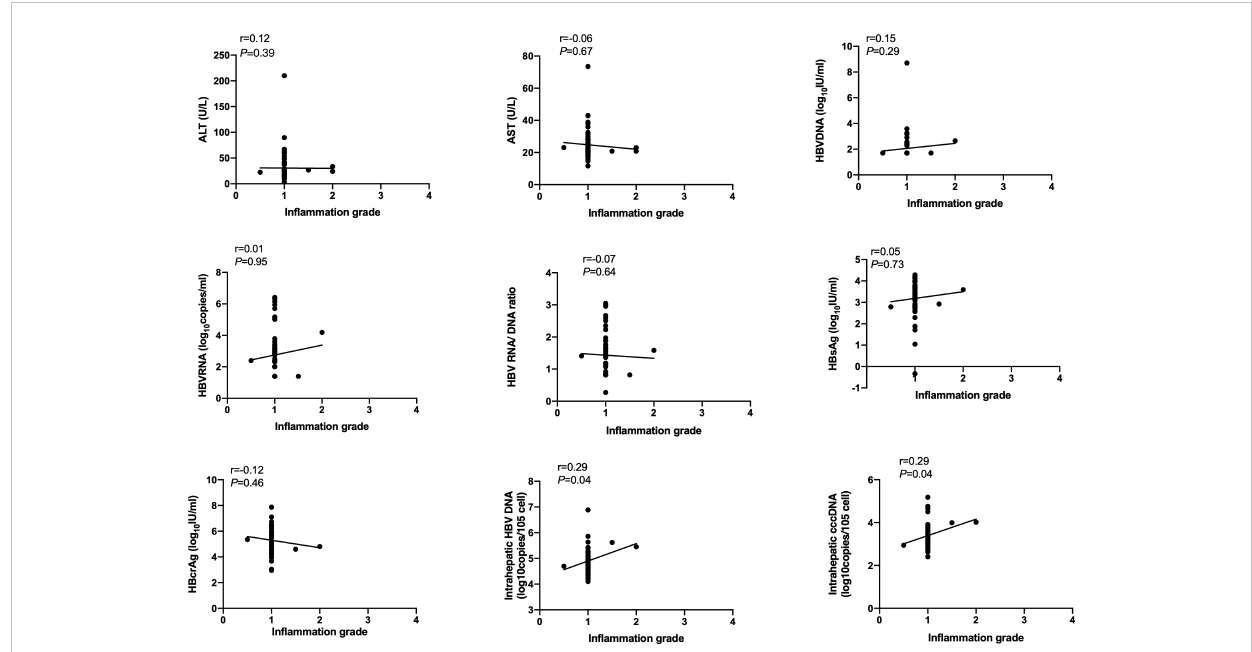
FIGURE 2 Correlation of HBV markers, ALT and AST with in fl ammation grade according to Scheuer scoring system in HBeAg-positive CHB patients after 60 months of NAs therapy. HBsAg, hepatitis B surface antigen; HBcrAg, hepatitis B core-related